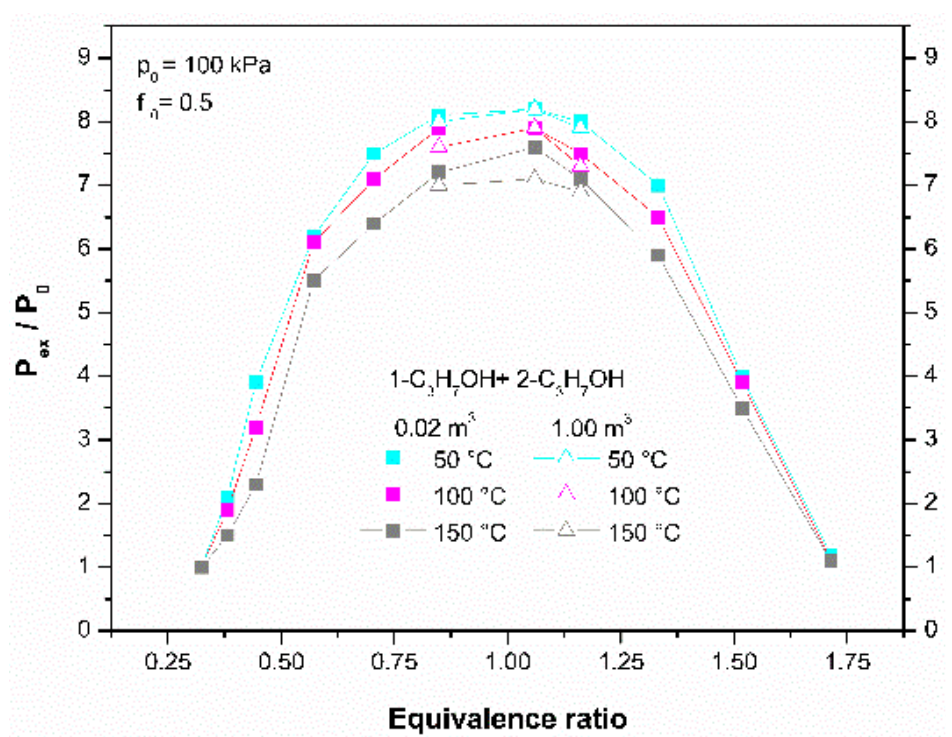
Figure 7. p ex /p 0 versus Φ = 0.3–1.7 for 1-propanol/2-propanol–air mixtures (f 0 = 0.5) at various initial Figure 7. p ex / p 0 versus Φ = 0.3–1.7 for 1-propanol / 2-propanol–air mixtures (f 0 = 0.5) at various initial volumes, temperatures, and mixture compositions, p 0 = 100 kPa. volumes, temperatures, and mixture compositions, p 0 = 100